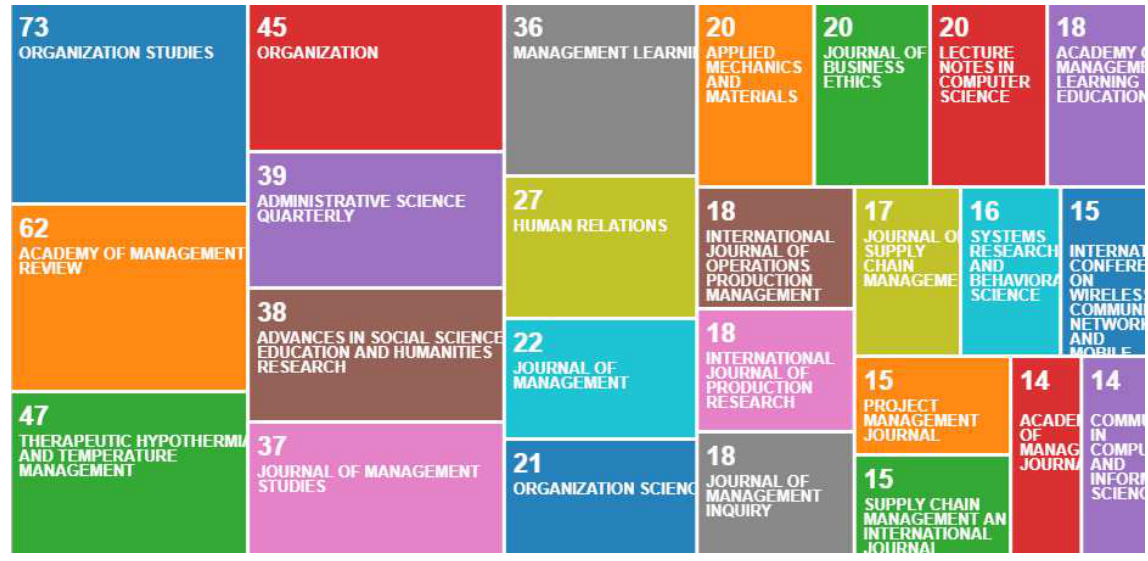
Figure 8. Main journals publishing articles in the management theory